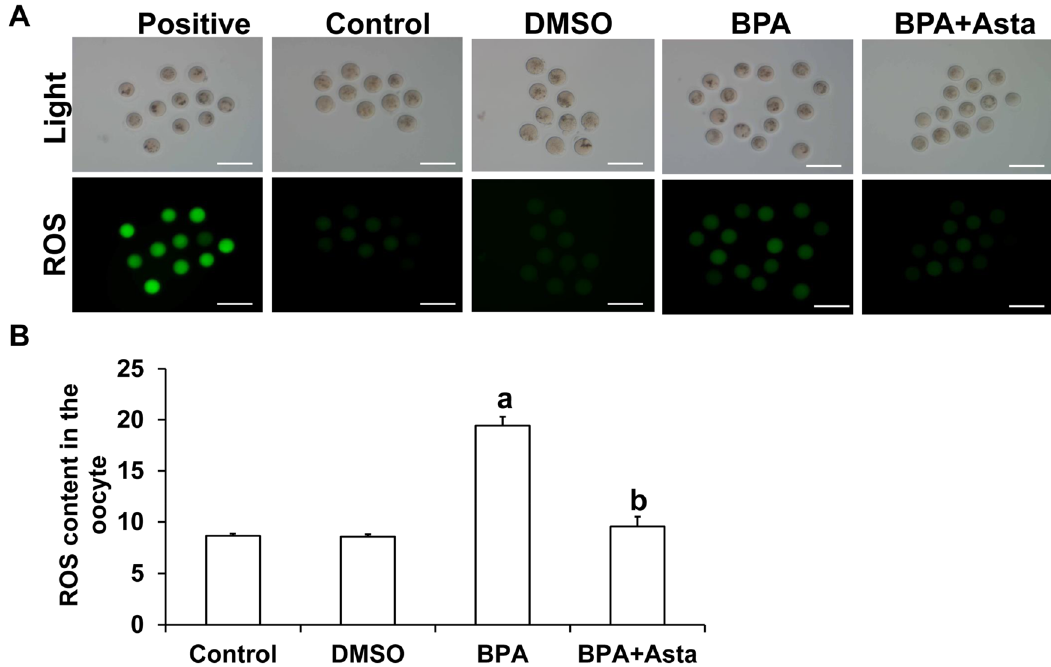
Figure 6. Analysis of ROS levels in oocytes. ( A ) Carboxy-H2DCF diacetate was used to detect the level of ROS in oocytes (Scale bar, 200 μm). ( B ) The average fluorescence intensity of ROS in oocytes was analyzed (N = 10). Compared with control, a P < 0.05; and compared with BPA group, b P <